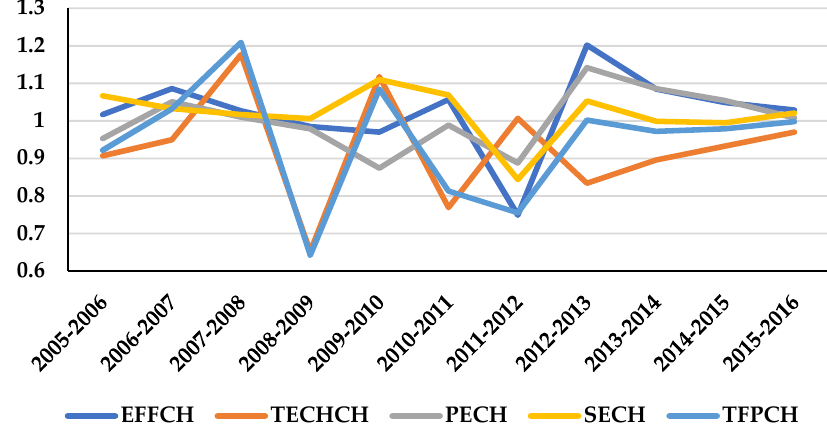
Figure 5. Evolution of the overall factor productivity index and its components.